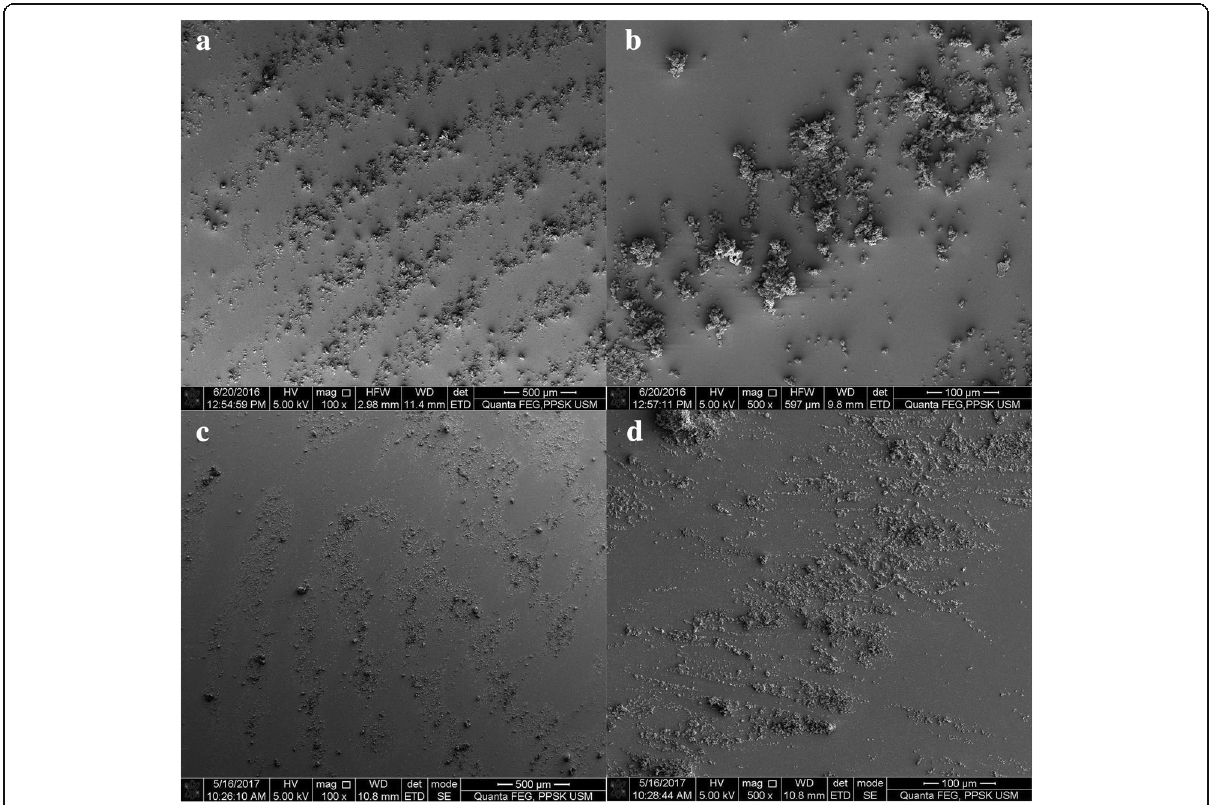
Fig. 3 SEM images of developed fingermark; NP ( a , b ), and BP ( c , d ) with natural fingermarks on glass